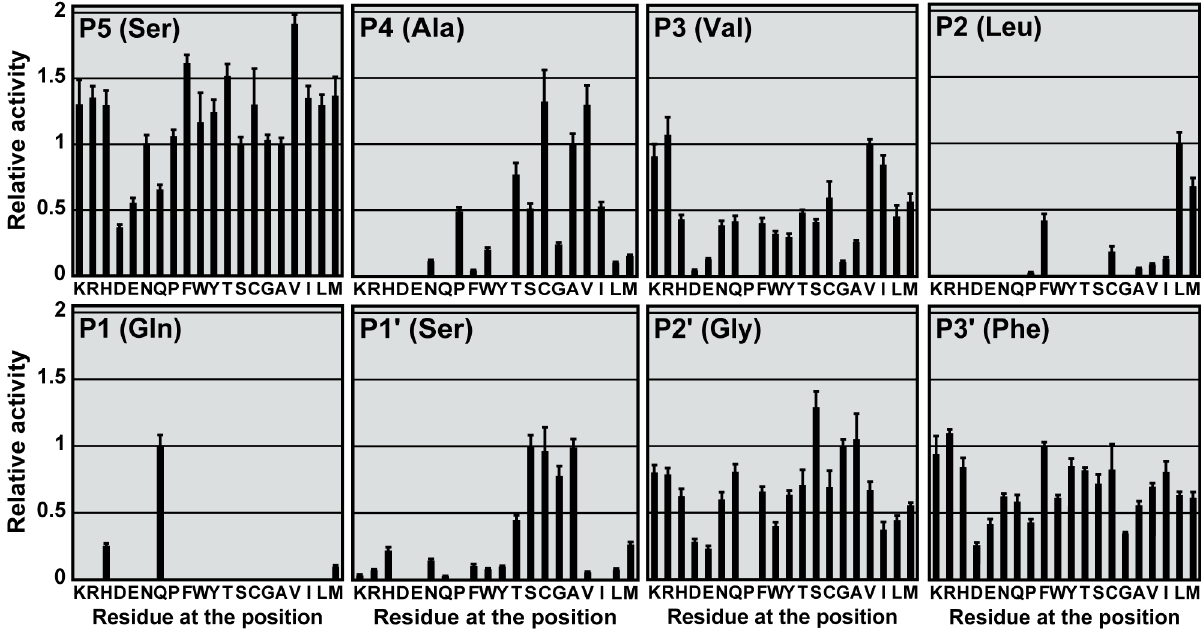
Figure 2. Profiling the substrate specificity at P5 to P3’ positions. 19 | 8 single substitution variants were created by saturation mutagenesis of the autocleavage sequence at P5 to P3’ positions. Specific activity on each of variants was determined, and normalized by that on WT substrate to obtain the relative activity.